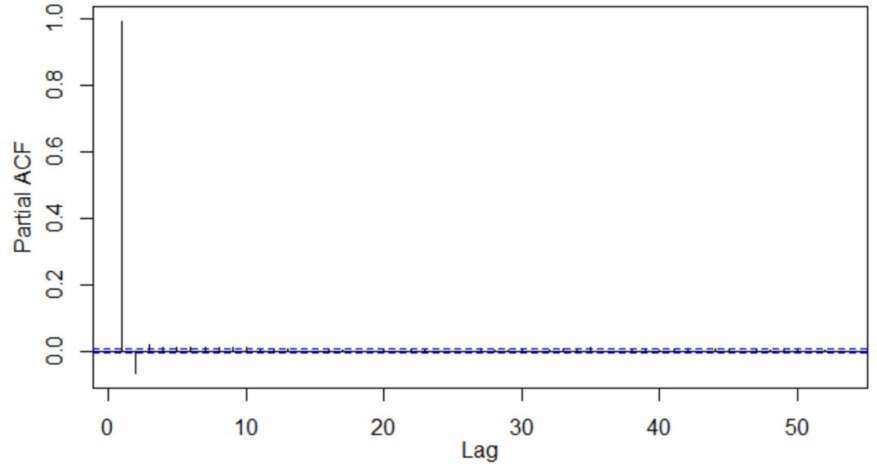
Figure 9. The partial autocorrelation function of the residual